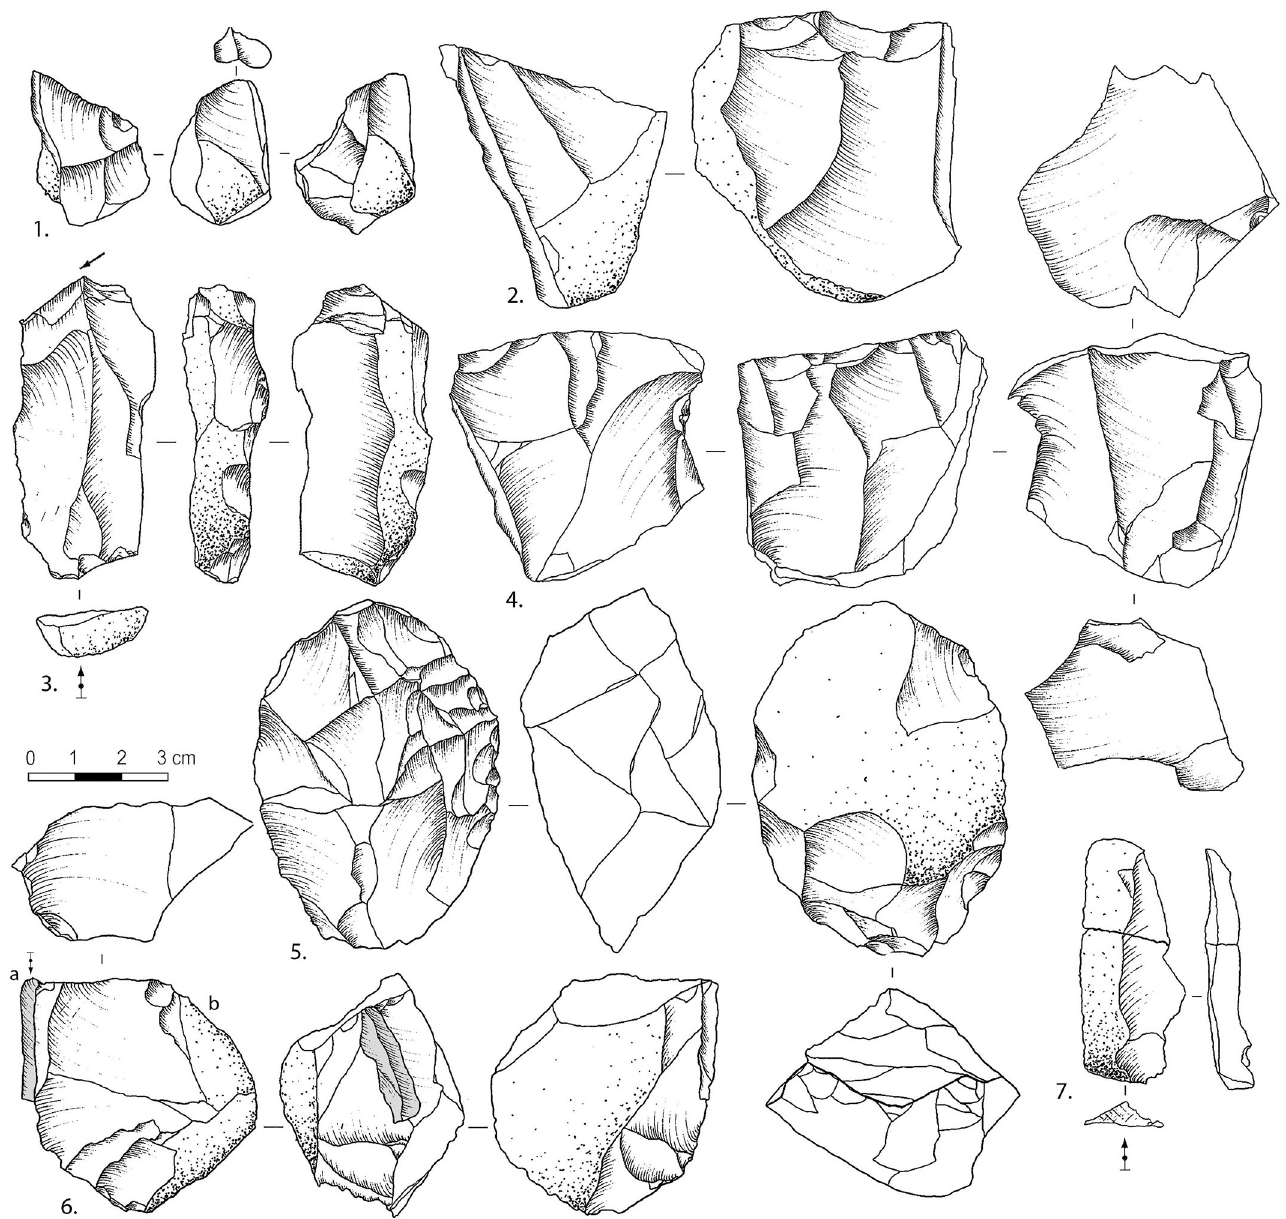
Fig 9. Variations in core shape and reduction method at CL3. A few known examples of atypical blank forms and core types in low frequency. 1, 2; 4–6, cores; 3, 7, flakes. Small flake core (1); Unidirectional asymmetrical core (2); Pseudo-burin on core-edge transverse flake (3); Bidirectional core (4); Discoid-like core (5); Discoid-like core (b) with a refitted accidental bladelet removal (a) (6); Elongated flake (7) (drawings by N.